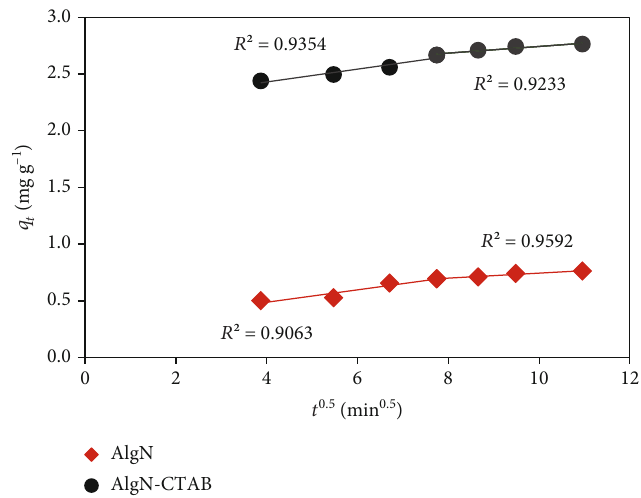
Figure 9: Linearized kinetic model of IPD on adsorption of MO dye. Table 2: Intraparticle di ff usion model for MO dye adsorption onto AlgN and AlgN-CTAB. Initial linear portion Second linear portion Adsorbent